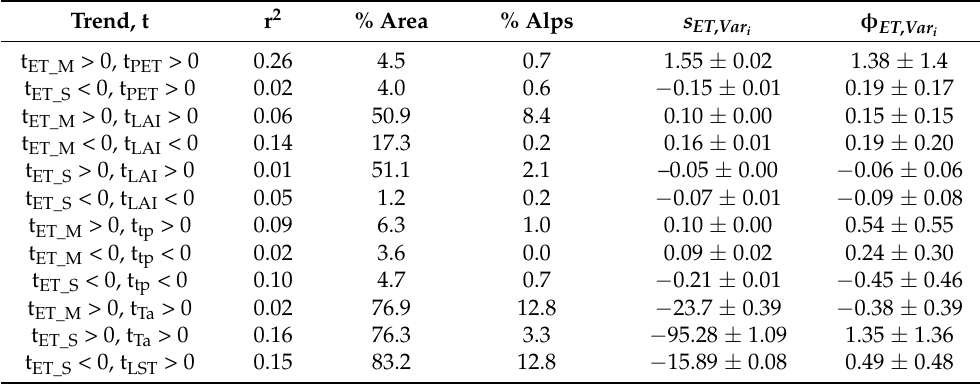
Table 6. Correlation and sensitivity analysis between ET trend and the trend of the predictors Var i , including PET, LAI, tp , Ta , and LST. The spatial extent of the area that originated these results is expressed as percentage of the area with a positive or negative ET trend (% area), and of the total area of the Alps (% Alps). s and φ are the slope of the linear regression and the average impact of the trend of a predictor on the trend of ET, with their respective uncertainties. t ET_M and t ET_S indicate the trend in ET from MOD16 (t ET_M ) and SSEBop (t ET_S ). t Ta_GS indicates the trend in air temperature cumulated over the growing season. p -value < 0.001 for all the estimated correlation coefficients. Results were omitted if r 2 < 0.01.